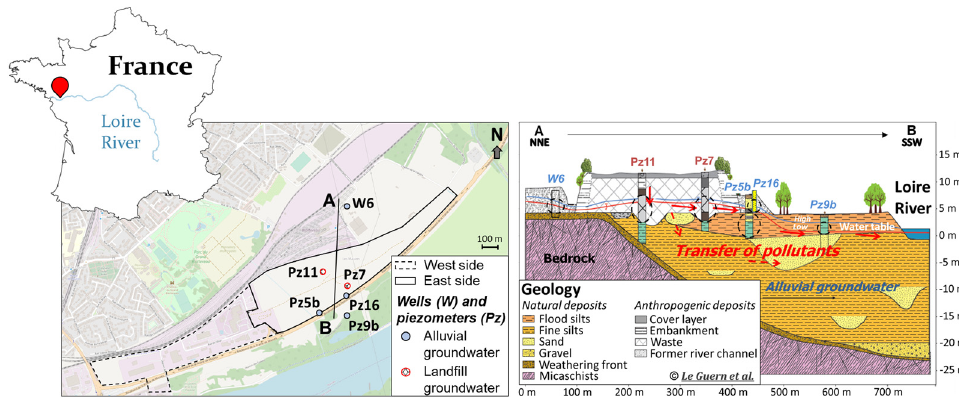
Figure 1. Location, map and geological cross ‐ section from north ‐ east (A) to south ‐ west (B) of the “Prairie de Mauves” landfill in Nantes (modified from [29]; Lat. 47.227003, Lon. ‐ 1.499305). Well and piezometers are indicated and represented according to the groundwater that they drain (red for the landfill groundwater, blue for the alluvial groundwater). Depth of groundwater tapped by the well and piezometers are indicated by black dotted circles. Arrows indicate the groundwater (in black) and therefore the pollutants (in red) flow direction.